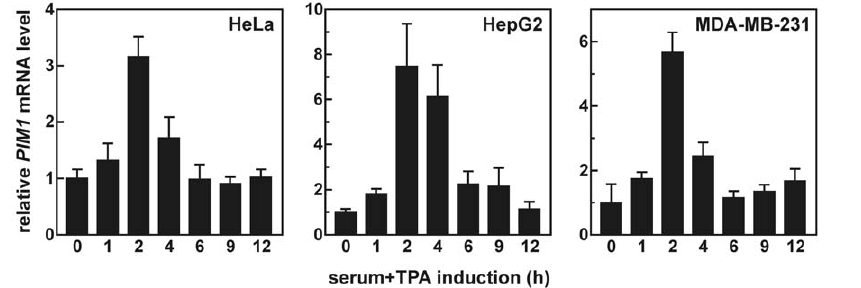
Figure 1. Transient induction of endogenous PIM1 mRNA by mitogenic stimuli in cancer cell lines. Total RNA was isolated from HeLa, HepG2, and MDA-MB-231 cells at selected times following stimulation with serum + TPA as described in ‘‘Materials and Methods’’. Bars represent the relative levels of PIM1 mRNA determined by qRT-PCR and normalized to GAPDH mRNA (mean 6 SD of quadruplicate qRT-PCR reactions). Independent replicate experiments yielded similar results.